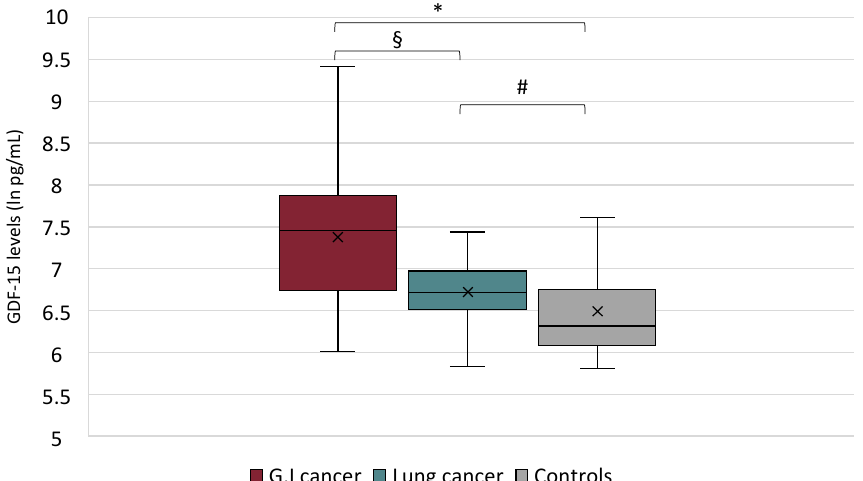
Figure 2. Growth Differentiation Factor 15 (GDF-15) serum levels in gastrointestinal (G.I.) vs. lung cancer patients and vs. controls (Kruskal–Wallis test p < 0.0001); § p = 0.0004; * p = 0.00006; # p = 0.008. Moreover, among all cancer patients, we observed a negative correlation between GDF-15 serum levels and FAACT score (r = − 0.280, p = 0.03) (Figure 3). No significant differences were seen in GDF-15 levels according to age and sex in both cancer groups and controls.